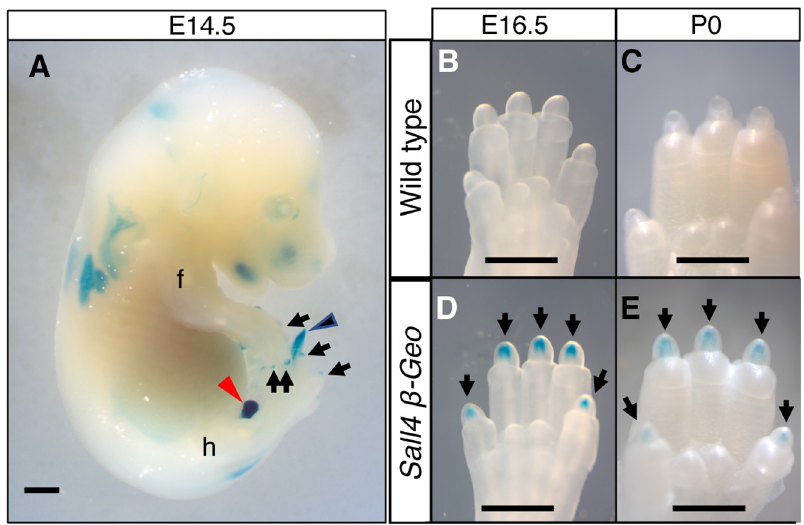
Fig 4. Sall4 expression at the digit tip. (A) Whole-mount LacZ stained Sall4 +/LacZ embryo at E14.5. Blue and red arrowheads point to signals at the tail tip and genital organ, respectively. Arrows point to signals at the digit tip. Scale bar, 1 mm. (B, C) Ventral views of the wild-type digit tip of the hindlimbs after lacZ staining at indicated stages. (D, E) Ventral views of the Sall4 +/LacZ digit tip of the hindlimbs after lacZ staining at indicated stages. Arrows point to the LacZ signals. Scale bar, 1 mm in A, 0.2 mm in B-E.